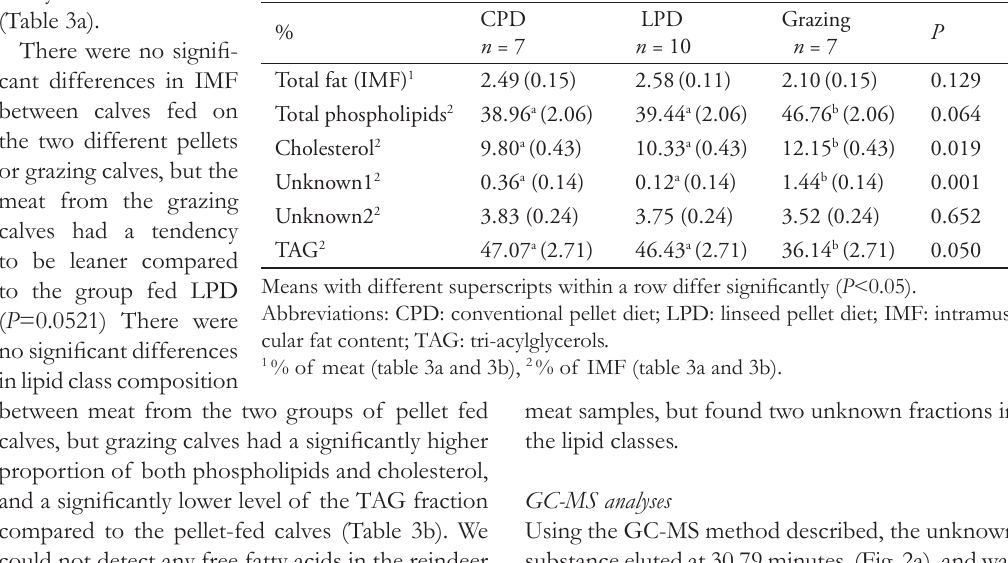
Table 3b. Fat content and main lipid class composition of reindeer calves fed different types of pellets compared to free ranging animals (least-square means and standard